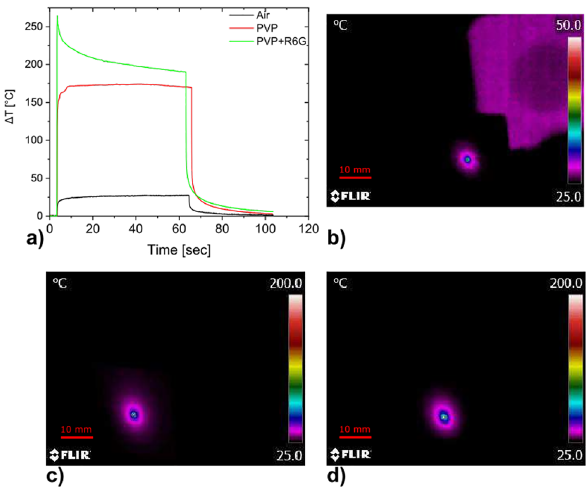
Figure 4: (a) Comparison of experimental macroscopic temperature acquired using an intensity of 14 W ∕ mm 2 . Experimental macroscopic thermal map after 30 s of excitation of (b) nano flower, (c) nano flower covered with 4 μ m thick PVP layer, (d) nano flower covered with 4 μ m thick PVP + R6G layer.